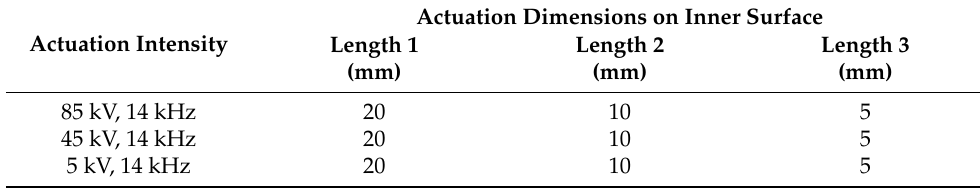
Table 3. Different actuation